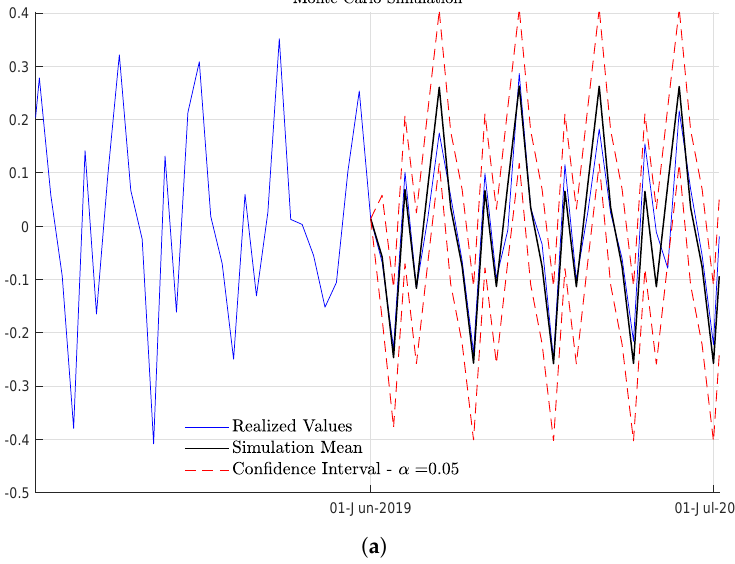
trajectories for the next month (30 days) by considering ten thousand Monte Carlo (MC) simulations under the assumption of NIG distributed errors. Let ˆ R value at t + j under the s -th MC trajectory, and MSPE t + j : = the mean squared prediction error of the whole set of simulated trajectories at t + j .